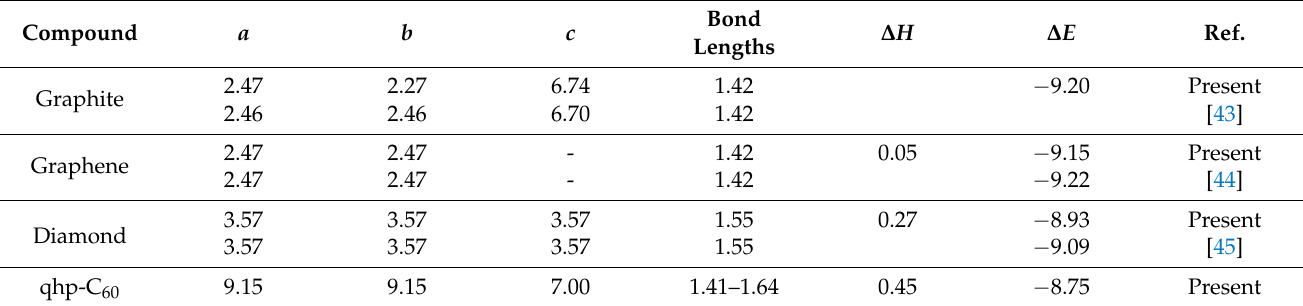
Figure 1. Crystal structure ( a – c ) qhp-C 60 , ( d ) graphite, and ( e ) diamond. Here, d A – d D , d E , and d F are the bond length of qhp-C60, graphite, graphene, and diamond. Table 1. Lattice constants (Å), bond lengths (Å), formation, and binding energies (eV/atom) of the four carbon materials.